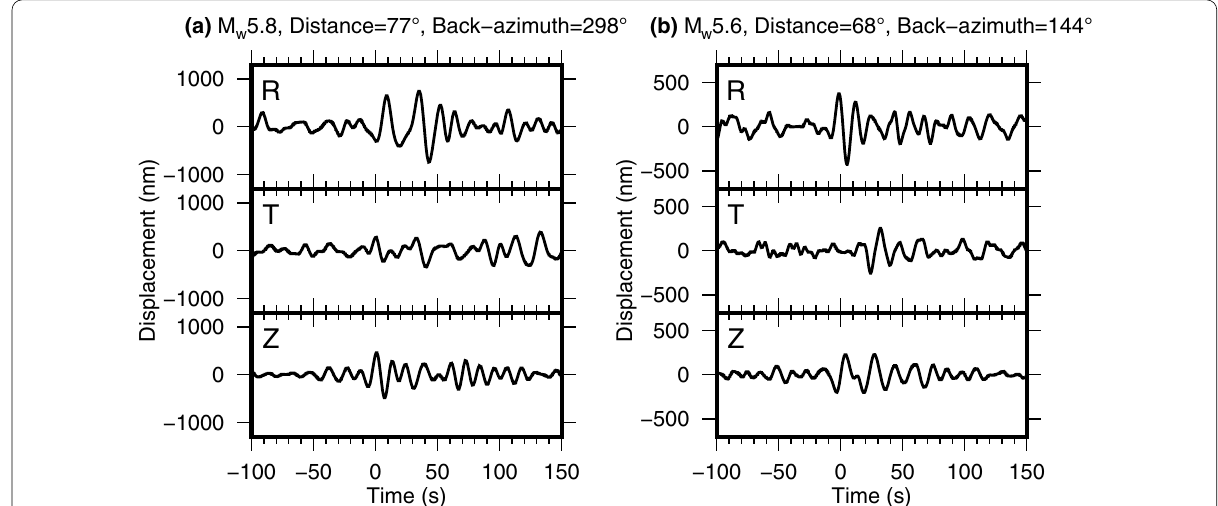
Fig. 2 Examples of teleseismic S waveforms recorded by a broadband ocean-bottom seismometer, YMB3 station. The waveforms are bandpass-filtered between 0.03 and 0.1 Hz. Zero on the time axis corresponds to the theoretical S arrivals. The magnitude, epicentral distance, and back-azimuth of the corresponding event are shown at the